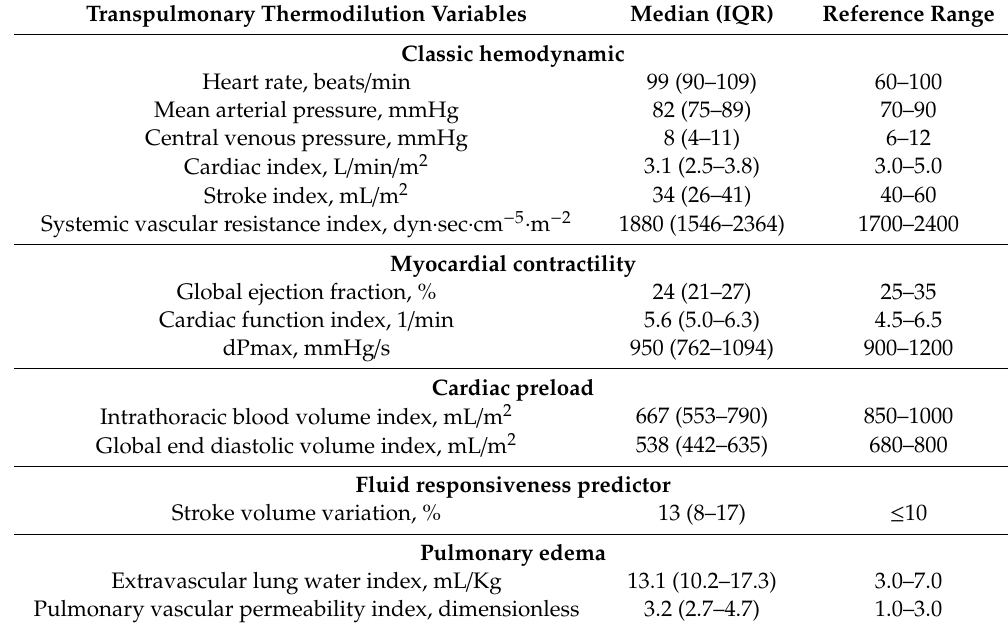
Table 2. Descriptive analysis of transpulmonary thermodilution (TPTD) variables. Data are expressed as median and interquartile range (IQR). Reference values are given for each variable. dPmax is the maximal change of arterial pressure per second.